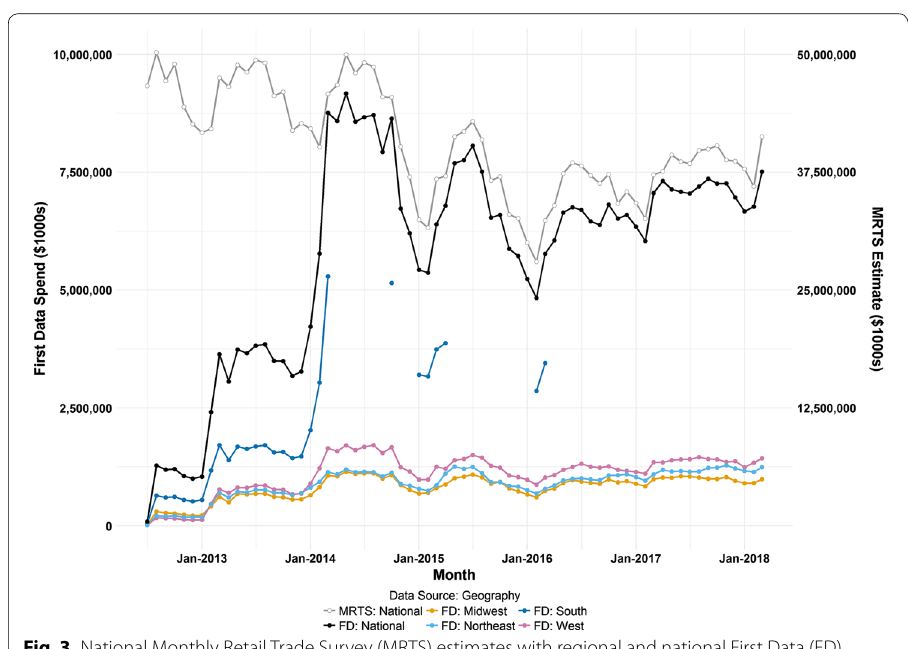
Fig. 3 National Monthly Retail Trade Survey (MRTS) estimates with regional and national First Data (FD) aggregate spend over time for NAICS 447 (gasoline